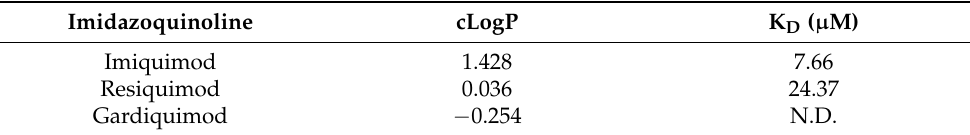
Table 1. cLogP and K D values of imidazoquinolines. cLogP was calculated using ChemDraw 19.1 Software—PerkinElmer. K D was estimated (sum of squares) from the membrane vesicle P-gp